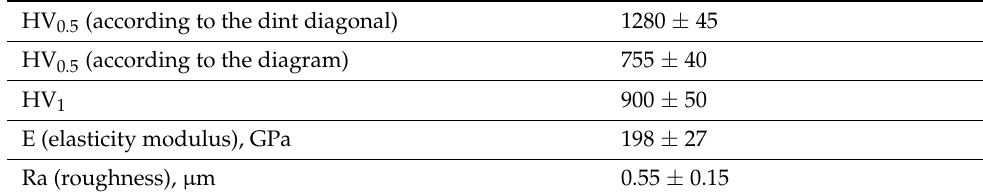
Table 10. Physical and mechanical parameters of the Ni-7Cr-3Fe + 60% WC coating. HV 0.5 (according to the dint diagonal) 1280 ± 45 HV 0.5 (according to the diagram) 755 ± 40 HV 1 900 ± 50 E (elasticity modulus), GPa 198 ± 27 Ra (roughness), µ m 0.55 ± 0.15